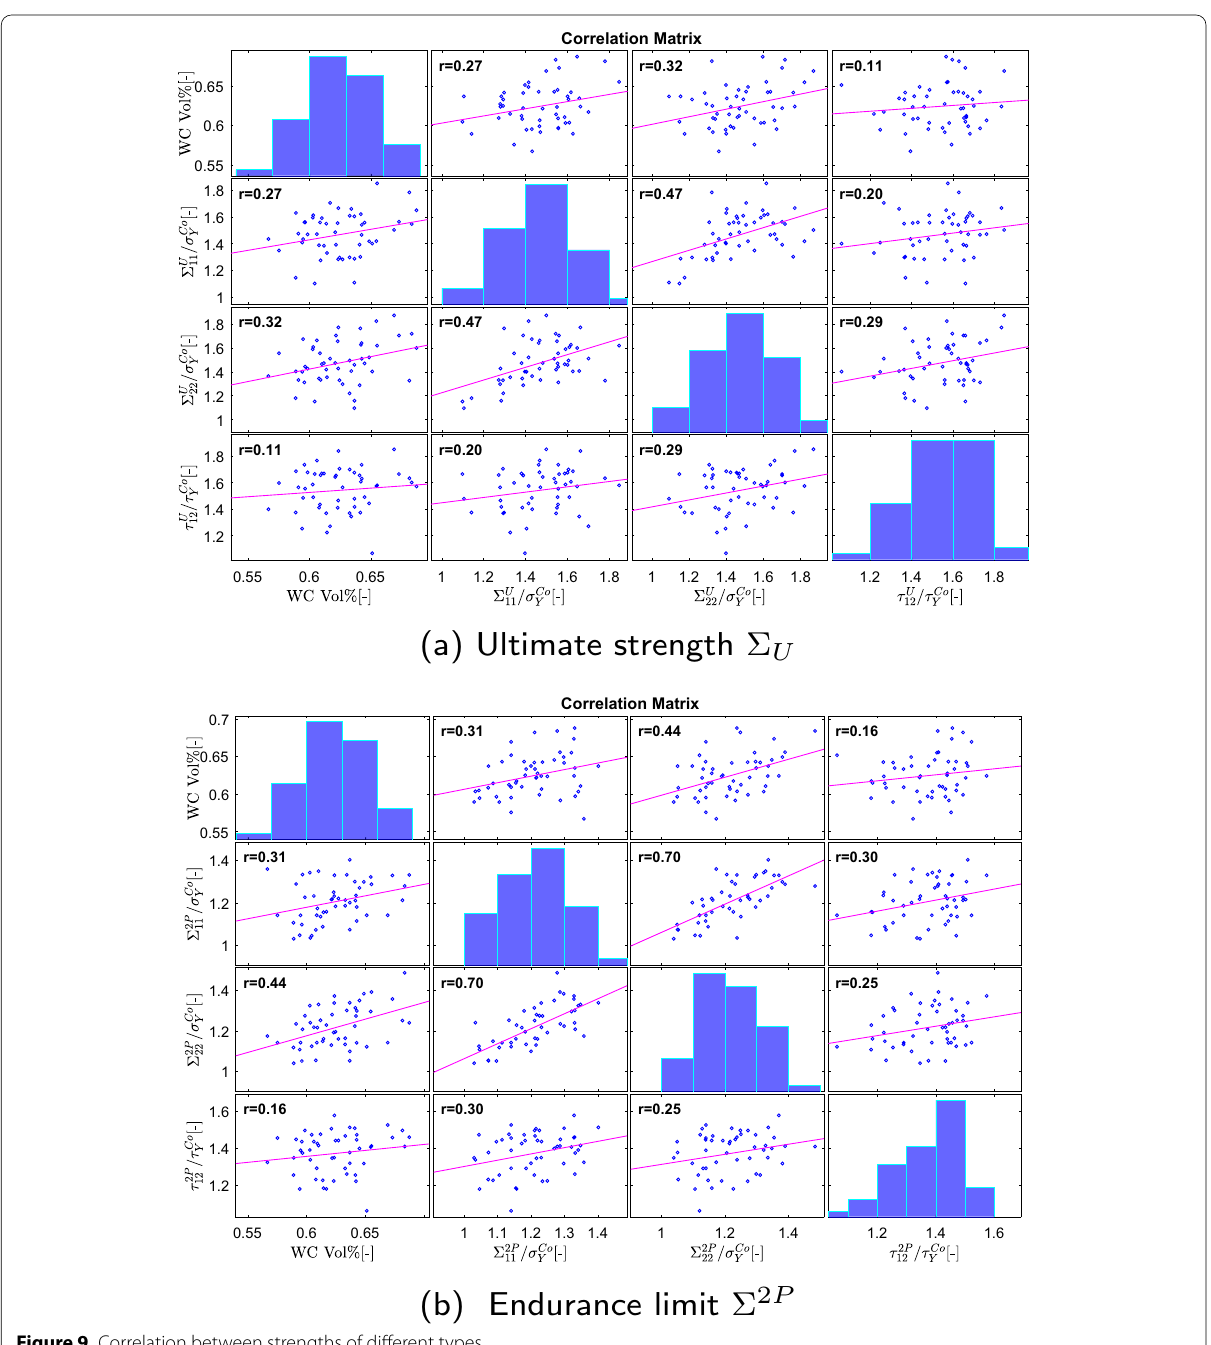
Figure 9 Correlation between strengths of different